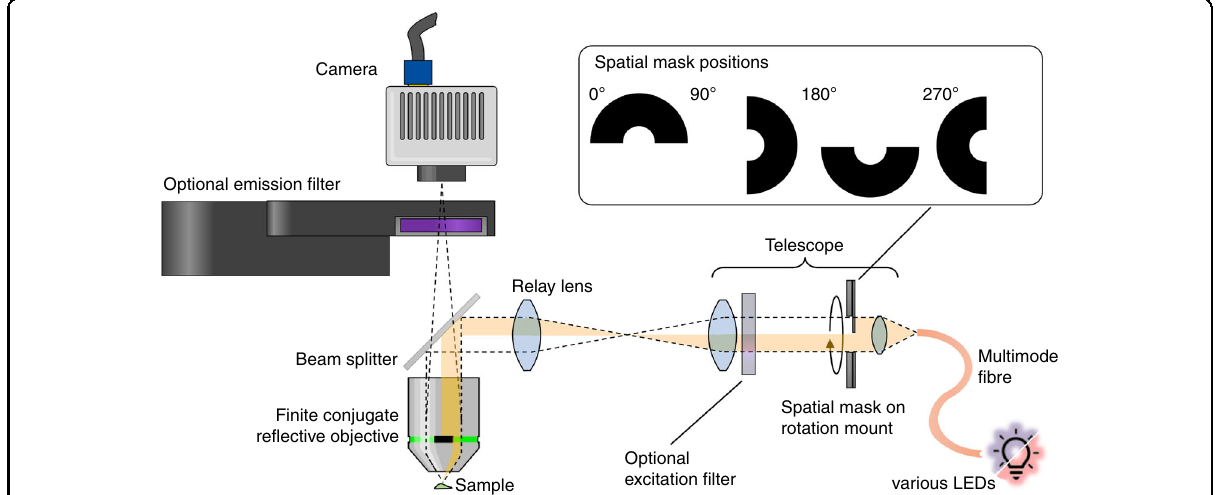
Fig. 2 Quantitative UVC microscope illuminated using a large-core multimode fi ber that collects narrowband LED light. The fi ber ’ s end-facet is relayed to the image plane through a lens relay that contains a rotatable half-ring mask in a pupil plane of the objective (see inlay). The light re fl ected from the sample is recorded by a fi nite conjugate Cassegrain-type objective (NA = 0.65) through a beam splitter onto a UV-sensitive camera. Emission and excitation fi lters can optionally be inserted into the beam path for (auto-) fl uorescence